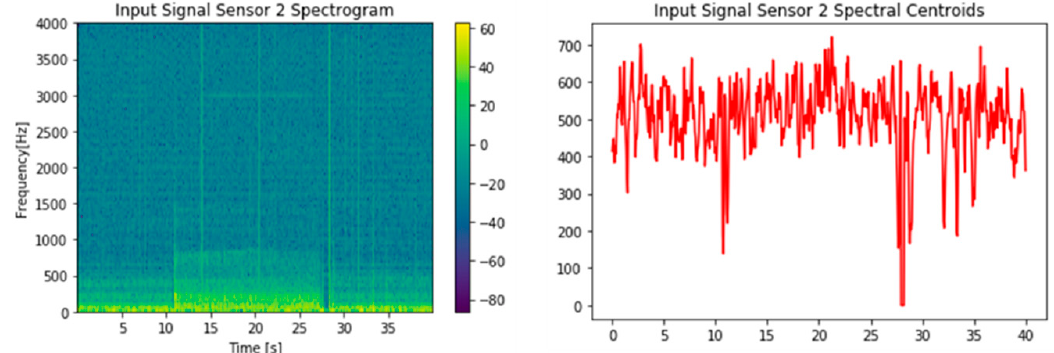
Figure 11. Isolating frequency ranges of interest using spectral centroids.